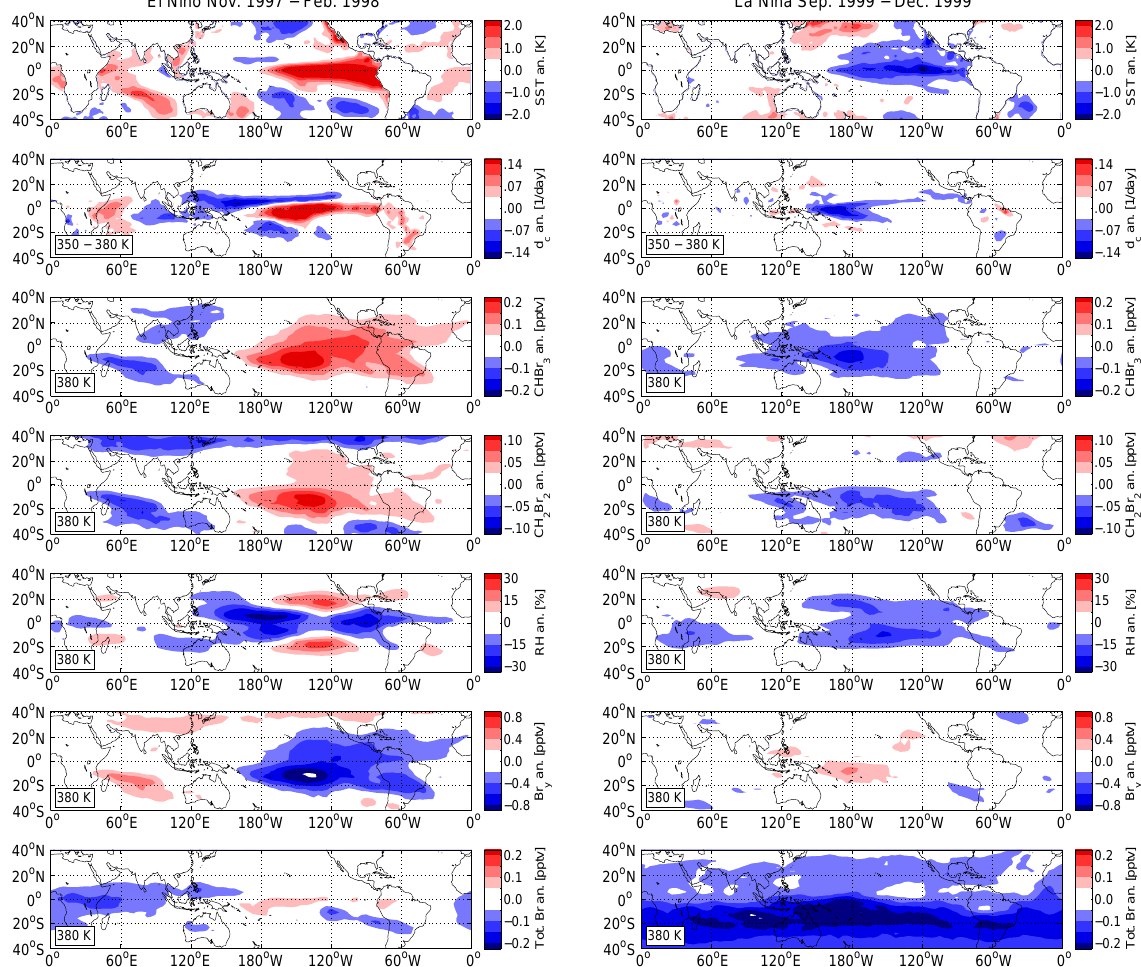
Fig. 12. Averaged anomalies for sea surface temperature, detrainment rate, bromoform, dibromomethane, relative humidity and inorganic and total bromine for the El Ni˜no season 1997/98 (left) and La Ni˜na season 1999 (right) as in Fig. 9 but for the full chemistry setup. Note: the values for Br y and total bromine are actually the difference of the full chemistry run without heterogeneous activation and the reference run without VSLS to show the impact of dehydration and short-lived substances (see also Sect.